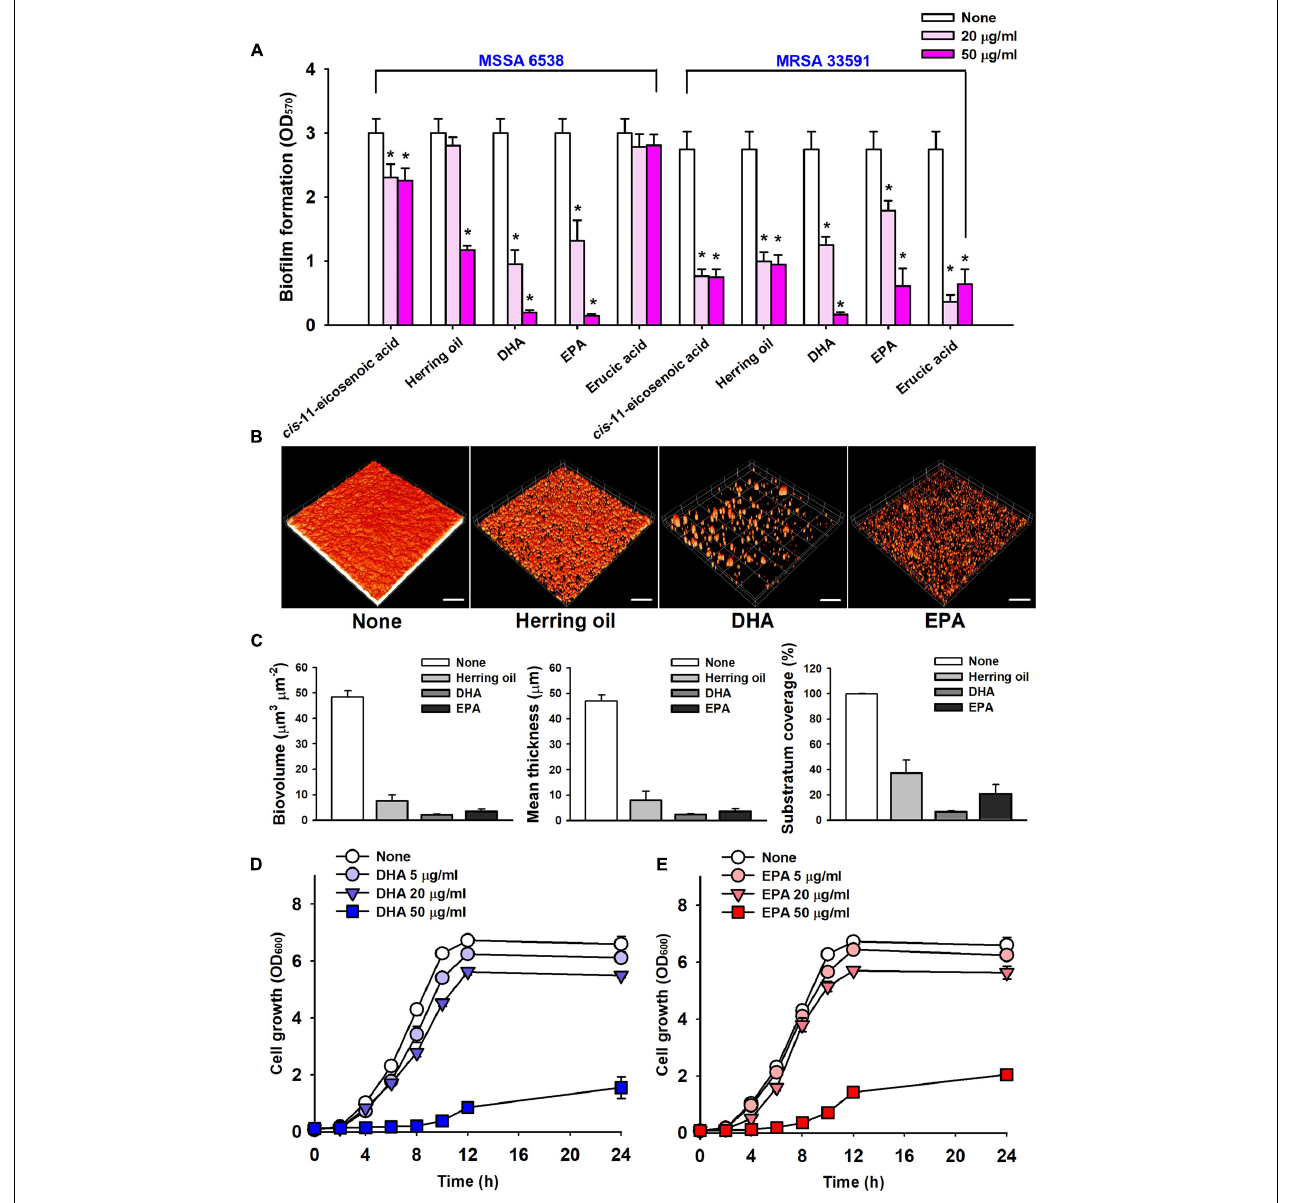
FIGURE 2 | Inhibitions of biofilm formation by herring oil, DHA, and EPA. Biofilm formations by the two S. aureus strains were quantified in the presence of cis -11-eicosenoic acid, herring oil, DHA, EPA, and erucic acid at 20 or 50 µ g/ml after incubation for 24 h in 96-well polystyrene plates without agitation (A) . Biofilm formation of S. aureus MSSA 6538 was observed after 24 h in the presence of herring oil (50 µ g/ml), DHA (20 µ g/ml), or EPA (20 µ g/ml) in 96-well plates by confocal laser scanning microscopy (B) . The scale bars represent 100 µ m. Biofilm formation was analyzed using COMSTAT (C) . Cell growth of S. aureus MSSA 6538 was measured in the presence of DHA or EPA (D,E) . ∗ p < 0.05 vs. non-treated